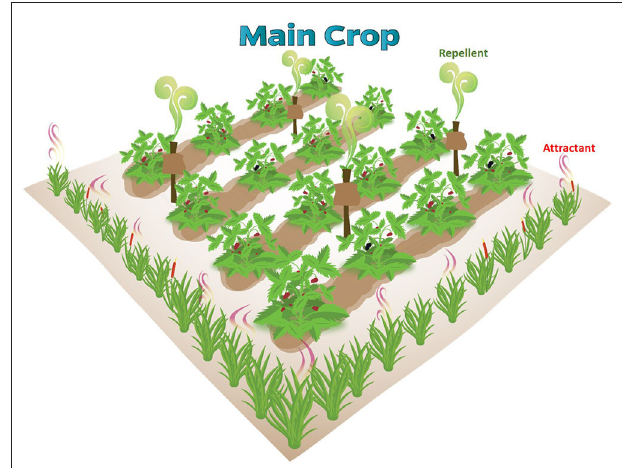
FIGURE 2 | A generic pull-push system for agricultural pest management. Microbial-based semiochemicals can replace or synergize non-microbial attractants and repellents in the pull-push